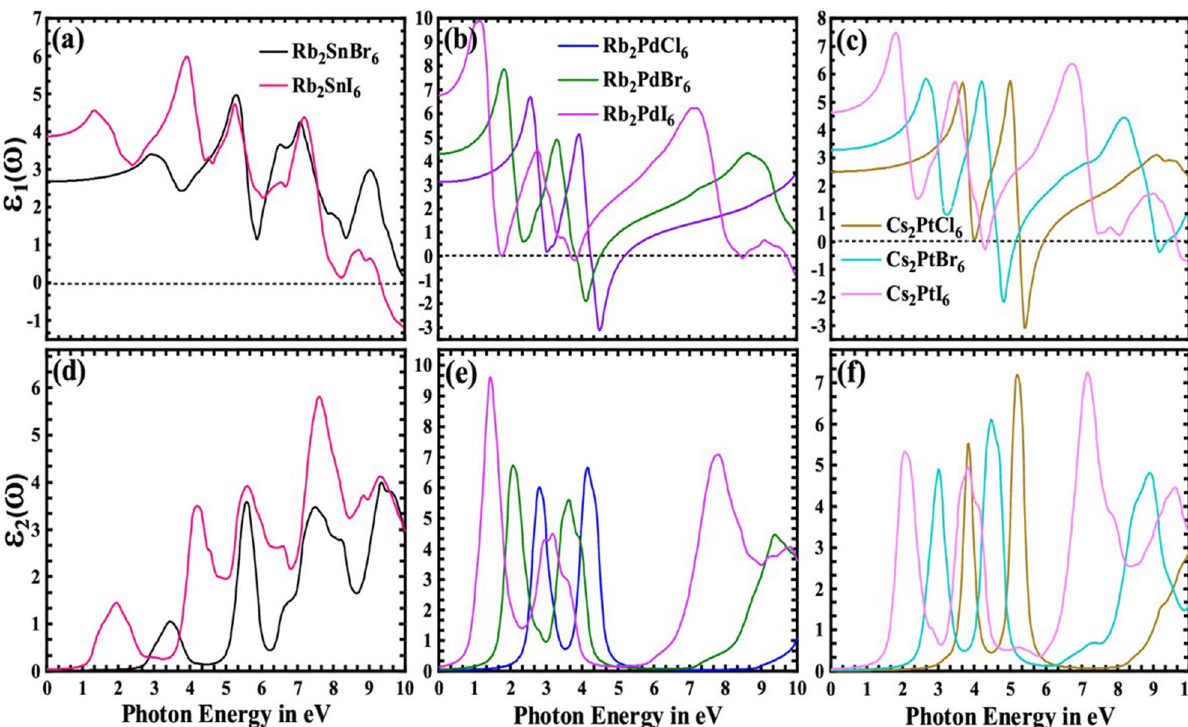
Figure 5. Real ( a – c ) and imaginary ( d – f ) part of the dielectric function for A 2 BX 6 (A = Rb, Cs; B = Sn, Pd, Pt; X = Cl, Br, I) computed using mBJ potential.